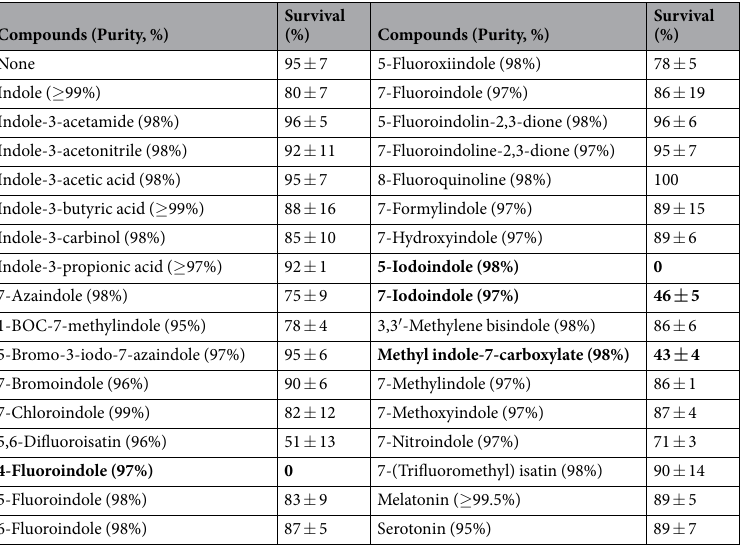
Table 1. Effect of indole and indole derivatives (1 mM) on the survival of B . xylophilus . Important changes are shown in